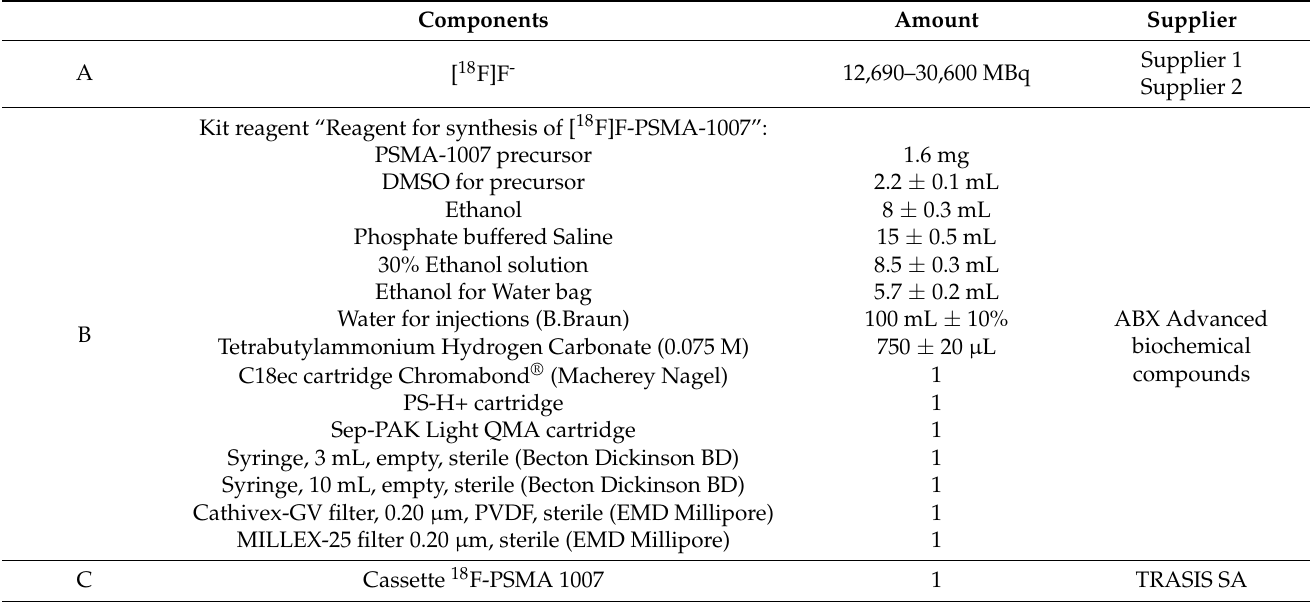
Table 7. Description of the synthesis